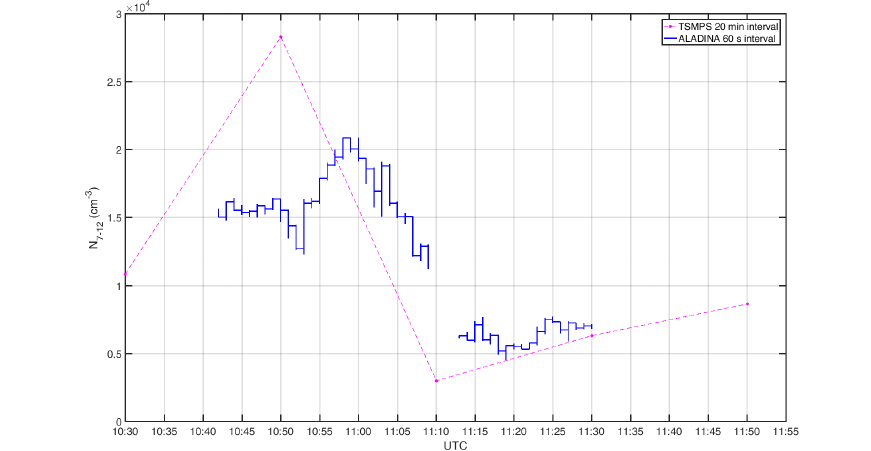
Figure 11. Comparison of the total aerosol particle number concentration in the diameter between 7 and 12nm measured at the same aerosol inlet with the two condensation particles counters (CPCs) in ALADINA (solid line, 1-min interval) and ground based instrumentation TSMPS (dashed line, 20min interval) sampling the same air on 21 June 2015 between 10:40 and 11:30 UTC in